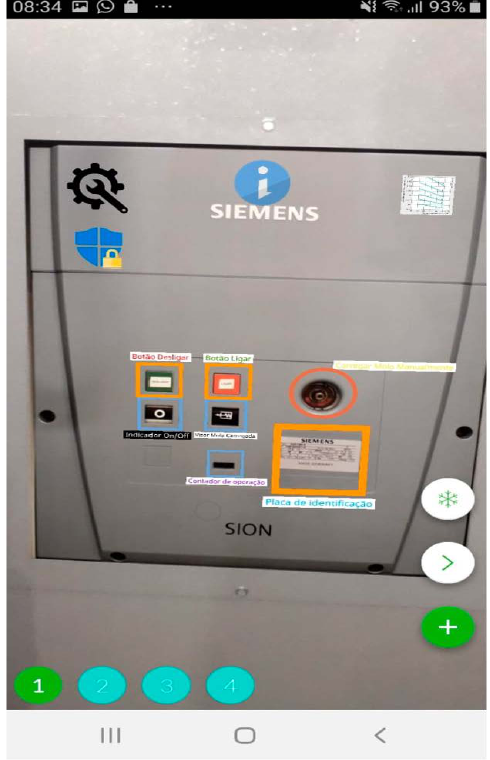
Figure 16. Augmented reality usage in an